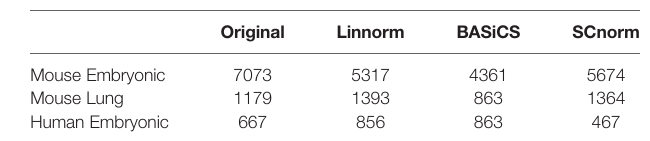
TABLE 4 | Number of DE genes detected by DESeq2 at the 0.05 signi fi cance level for the original data and data normalized by three methods (Linnorm, BASiCS, and SCnorm) for three data sets.